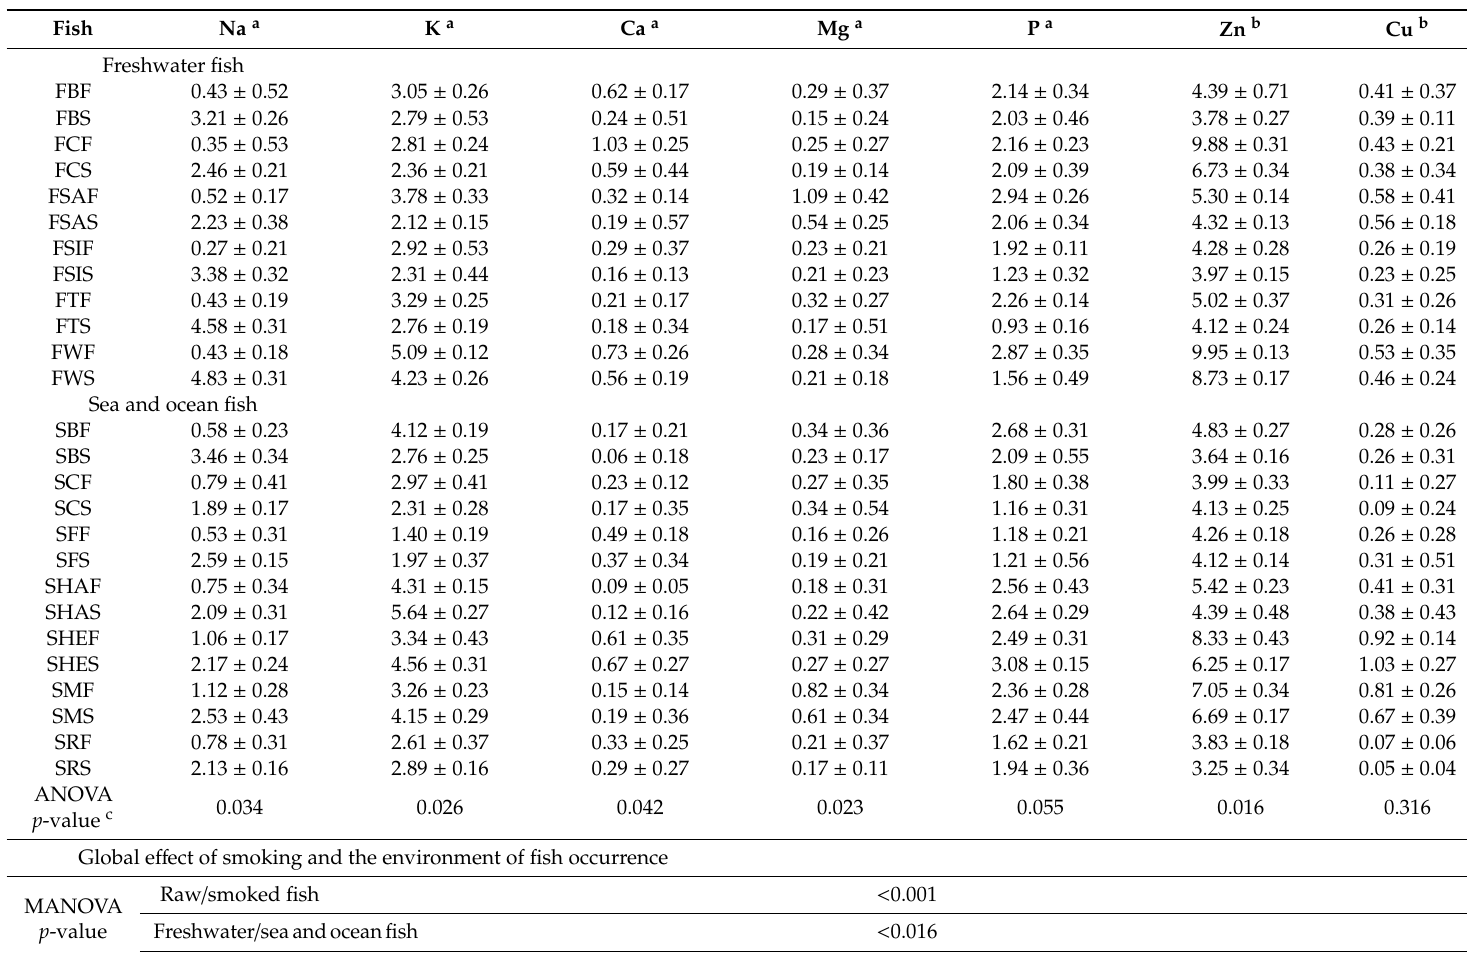
Table 3. Macroelements a (g · kg − 1 fish) and microelements b (mg · kg − 1 fish) of fresh and smoked